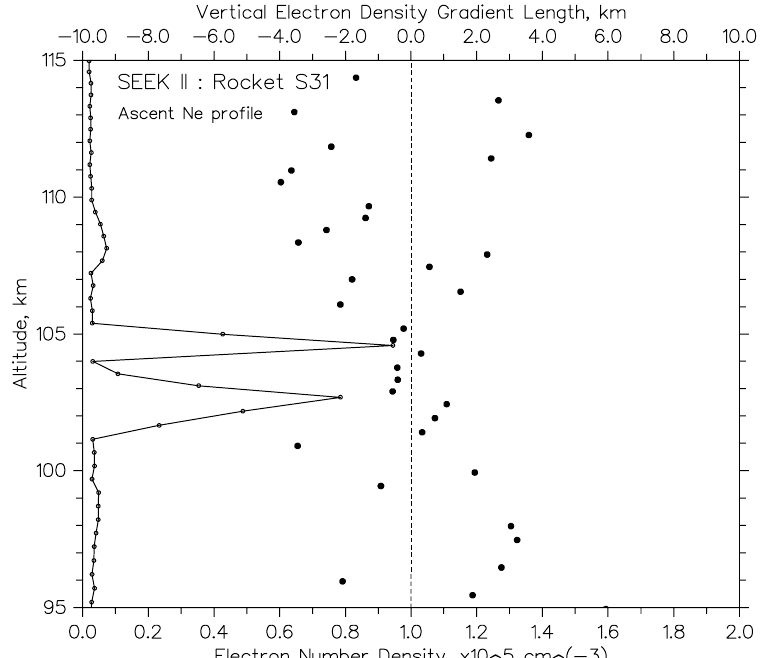
Fig. 2. Typical SEEK rocket sporadic E electron density profile (solid line) and computed vertical plasma density scales (dots) expressed in kilometers. Positive (negative) gradient lengths means density gradients pointing upward